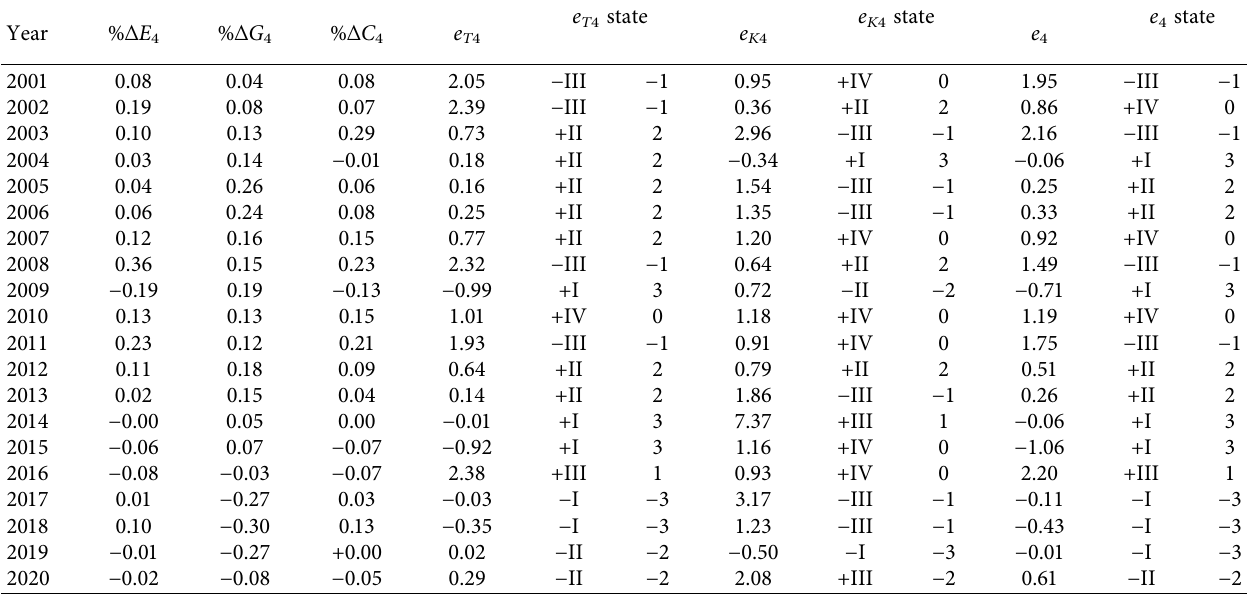
Table 11: Decoupling index and decoupling relationship of the nonferrous metal sector from 2001 to 2020.